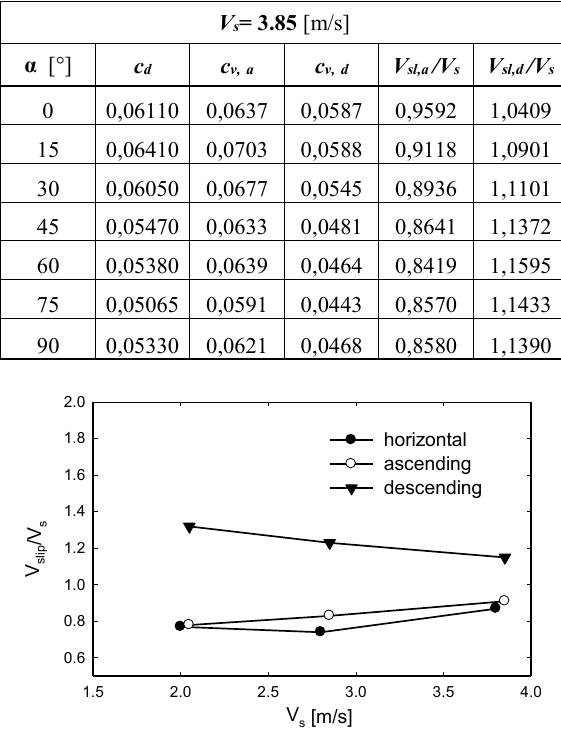
Fig. 3. Slip ratio V slip /V s in horizontal and vertical pipe